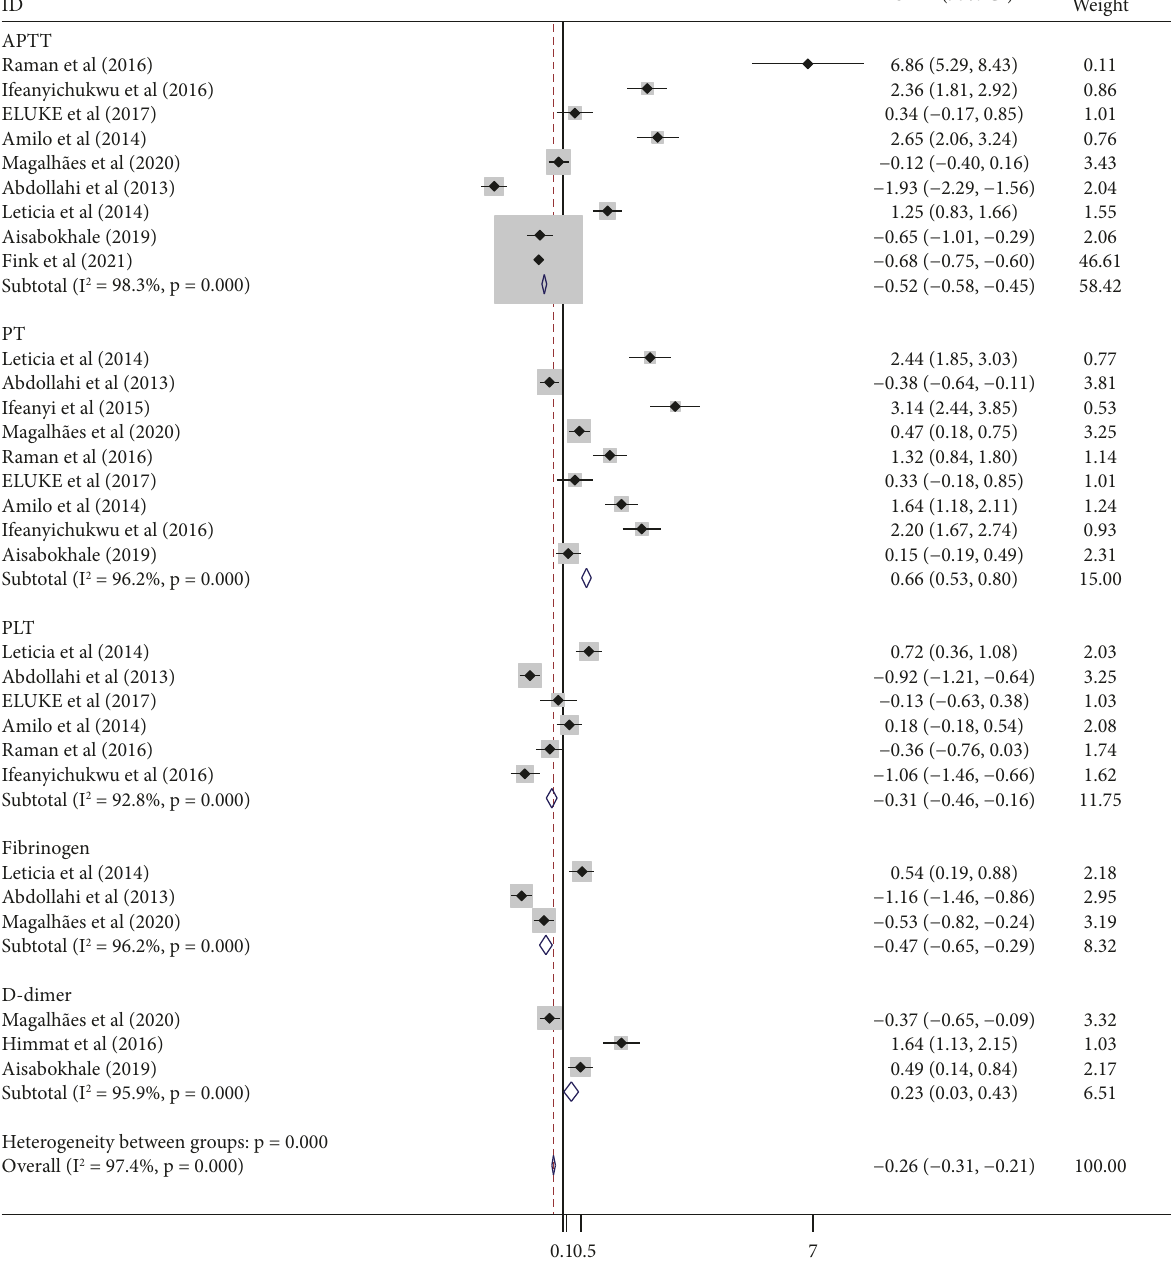
Figure 2: Forest plot displaying a comparison of coagulation parameters between HAART-treated HIV-infected patients and seronegative